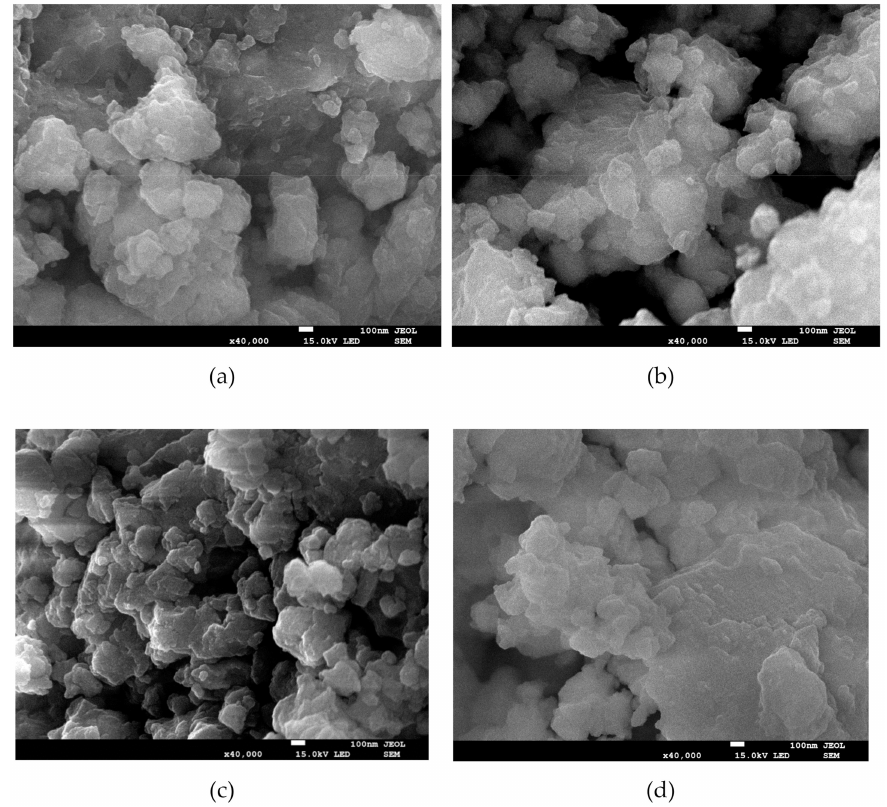
Figure 2. SEM micrographs of powders after 25 h ( a ), 50 h ( b ), 75 h ( c ), and 100 h ( d ) of high energy milling.